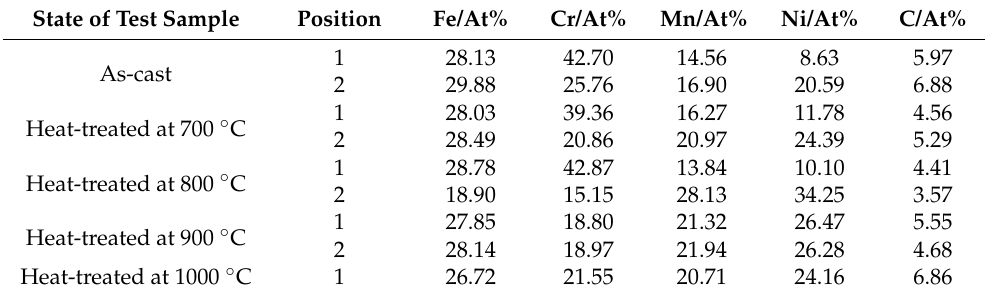
Table 2. EDS analysis results of FeCrMnNialloy micro-zones shown in Figure